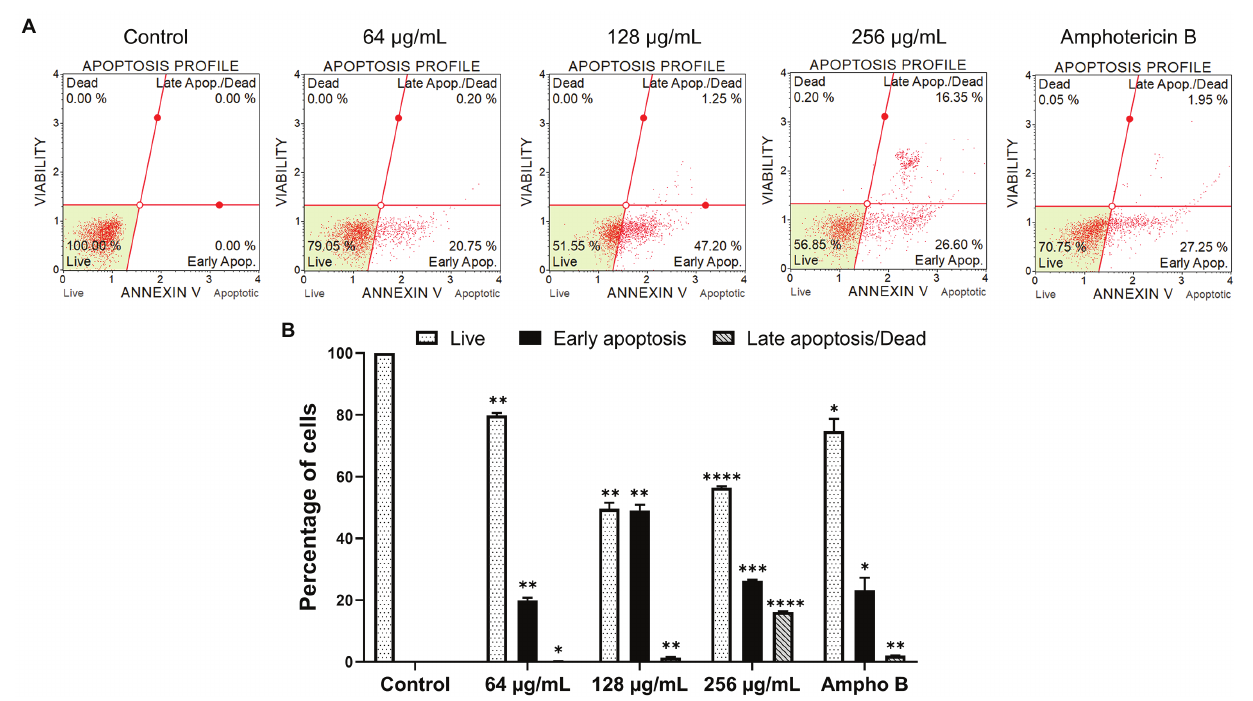
FIGURE 7 | Effect of β -citronellol on Candida albicans apoptosis. Cells were incubated with β -citronellol (64–1,256 μ g/ml) and amphotericin B (2 μ g/ml) for 6 h. (A) Chromatogram of the apoptosis profile of Candida albicans in different conditions. (B) Rate of positive cells in each phase including live, early apoptosis and late apoptosis/dead. Data are represented as mean ± SD. * p ≤ 0.05, ** p ≤ 0.01, *** p ≤ 0.001, and **** p ≤ 0.0001 compared to the control.